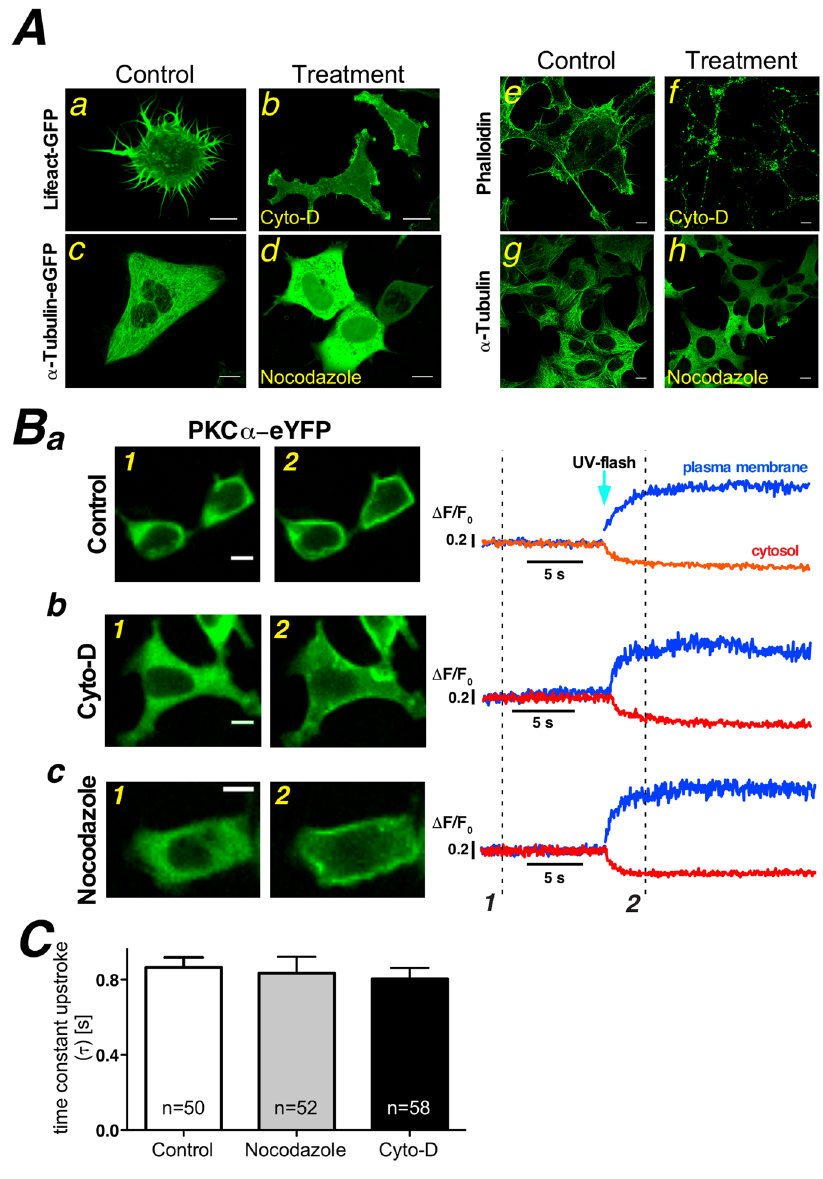
Figure 3. Depolymerization of actin filaments and microtubules does not alter Ca 2 + induced PKC α translocation. ( A ) Cytochalasin-D (4 µ M, 2 hours) (b,f) or nocodazole (10 µ M, 2 hours) (d,h) treatment of HEK cells, either expressing Lifeact-GFP (a,b) and α -tubulin-eGFP (c,d), staining with phalloidin (e,f) or immunofluorescence with primary antibodies against α -tubulin (g,h), results in depolymerisation of actin filaments (b,f) and microtubules (d,h), respectively. Note that the confocal sections in Aa and Ab were deliberately close to the bottom of the cell to highlight the spiky plasma membrane protrusion while all other confocal sections were placed in the middle of the nucleus. ( B ) Exemplified single images of PKC α - eYFP distribution before (Ba1, Bb1, Bc1) and following (Ba2, Bb2, Bc2) photolytic Ca 2 + increase at the time points marked in the traces to the right. Three different experimental conditions are depicted (Ba-control, Bb-cytochalasin-D treatment, Bc- nocodazole treatment). Traces were generated from regions of interest in the cytosol (red traces) and on the plasma membrane (blue traces). ( C ) The plasma membrane accumulation was characterized by fitting an exponential to the upstroke following the flash photolytic Ca 2 + increase. The statistical summary demonstrates that the state of polymerization of the cytoskeleton does not influence the speed at which PKC α -eYFP accumulates at the plasma membrane after Ca 2 + UV flash photolysis. Numbers given on the bars indicate number of cells in at least 5 independent